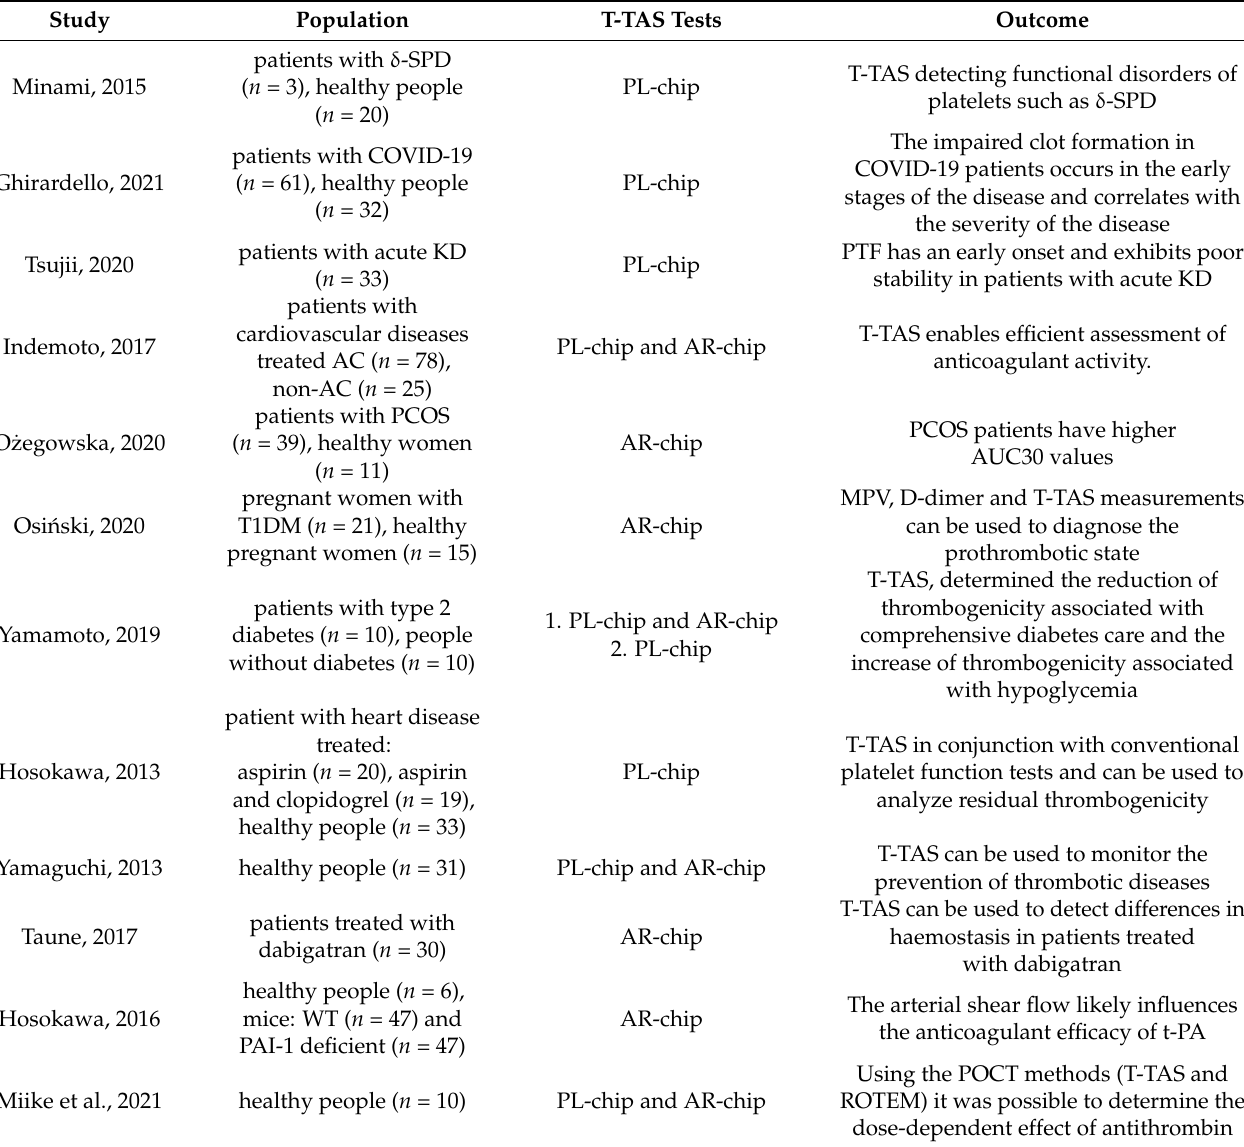
Table 1. Comparison of studies with the application of T-TAS in platelet function (AC—anticoagulant, AUC30—area under the flow pressure curve for the first 30 min, COVID-19—coronavirus disease 2019, δ -SPD—platelet δ -storage pool disease, KD—Kawasaki disease, MPV—mean platelet volume, PAI-1—plasminogen activator inhibitor-1, PCOS—polycystic ovary syndrome, POCT—point-of-care, PTF—platelet thrombus formation, ROTEM—thromboelastometry,